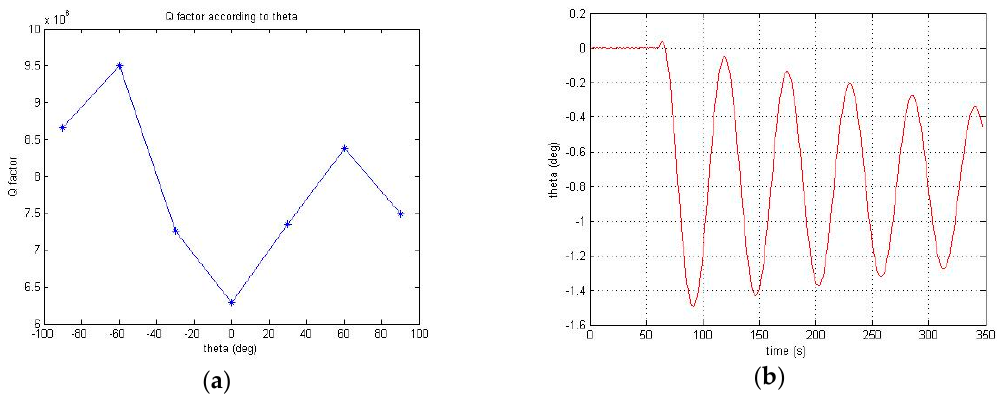
Figure 16. A estimate of the Q, Δ Q and Δ f by using the controllers: ( a ) Measured Q-factor in according to target angle θ ; ( b ) Vibration of the target angle θ .